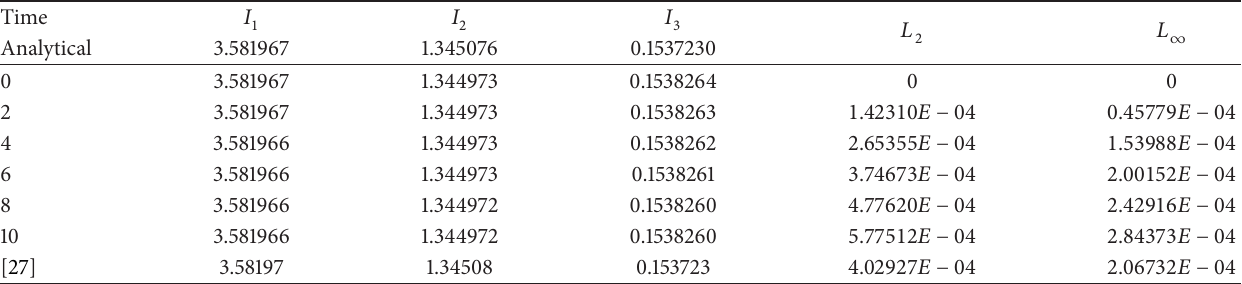
Table 4: Invariants and error norms for single solitary wave, 𝑐 = 0.3 , ℎ = 0.1 , 𝑘 = 0.01 , 𝑥 0 = 40 , and 0 ≤ 𝑥 ≤ 100 (using Crank-Nicolson time discretization).